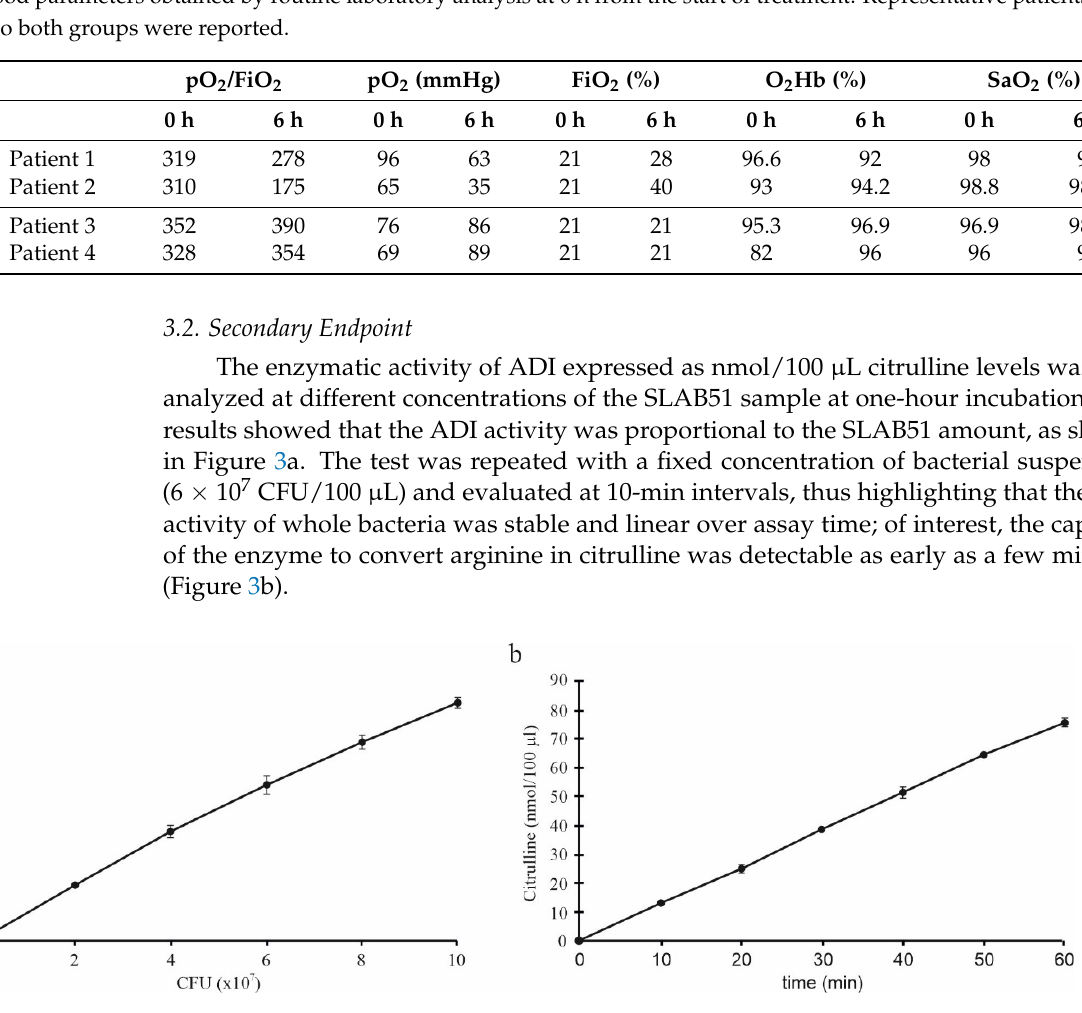
Figure 3. ADI activity in SLAB51 sample. ( a ) Citrulline levels (nmol/100 μ L) after 1 h incubation with different amounts of SLAB51 suspension (×10 7 /100 μ L); ( b ) kinetics of ADI activity of SLAB51 at 6 × 10 7 CFU/100 μ L. Data are expressed as mean of two measurements ± SD.